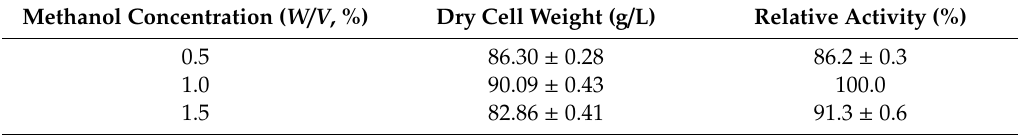
Table 1. E ff ect of di ff erent methanol concentrations on P. pastoris cell growth and enzyme activity. Methanol Concentration ( W / V ,